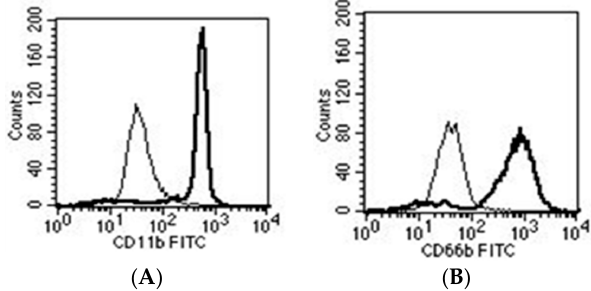
Figure 3. After stimulation with GroEL, neutrophils upregulated the activation markers CD11b ( A ) and CD66b ( B ) as shown by cytofluorometry (thin line: control, thick line: after stimulation with GroEL).